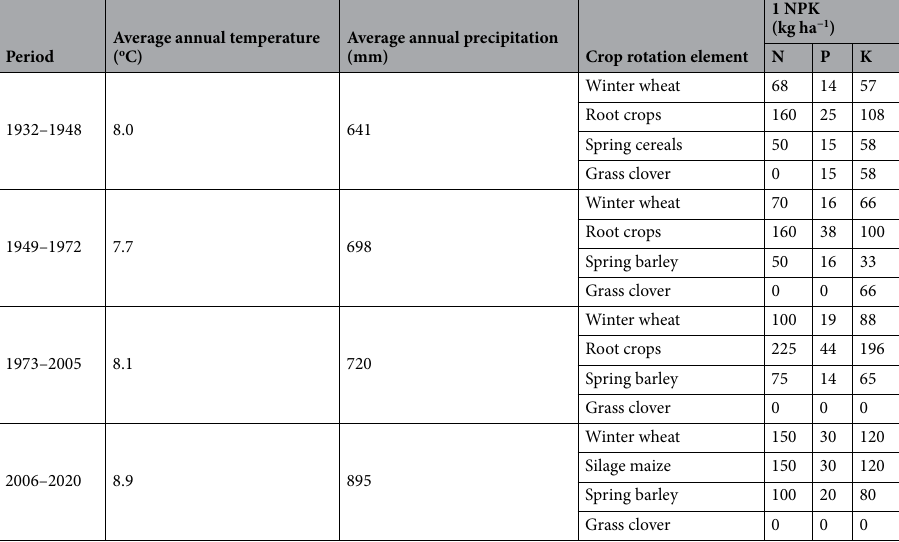
Table 1. Average annual temperature and precipitation during 1932–2020, crops included in the four-course rotation, and amounts of nutrients added in the 1 NPK (mineral fertilizer) treatment. Data from Christensen et al. (2019) 19 and Macholdt et al. (2021) 20